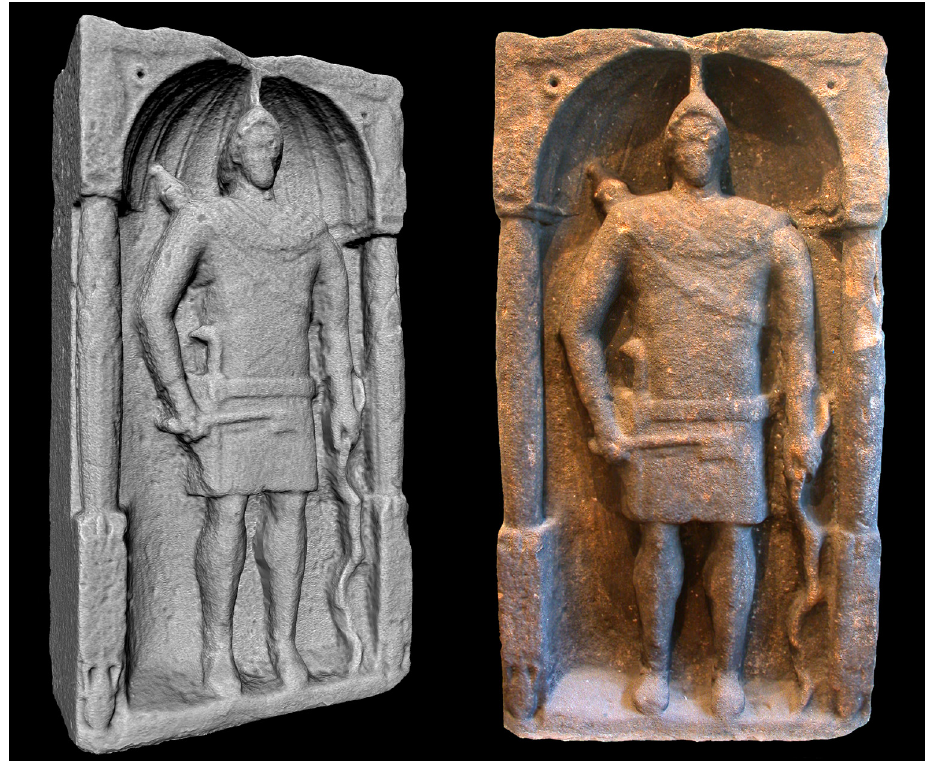
Figure 6. Comparison of an untextured orthographic render of the Housesteads archer captured by the Artec EVA (left) with a photograph of the monument in its present condition (right) (Image: R.